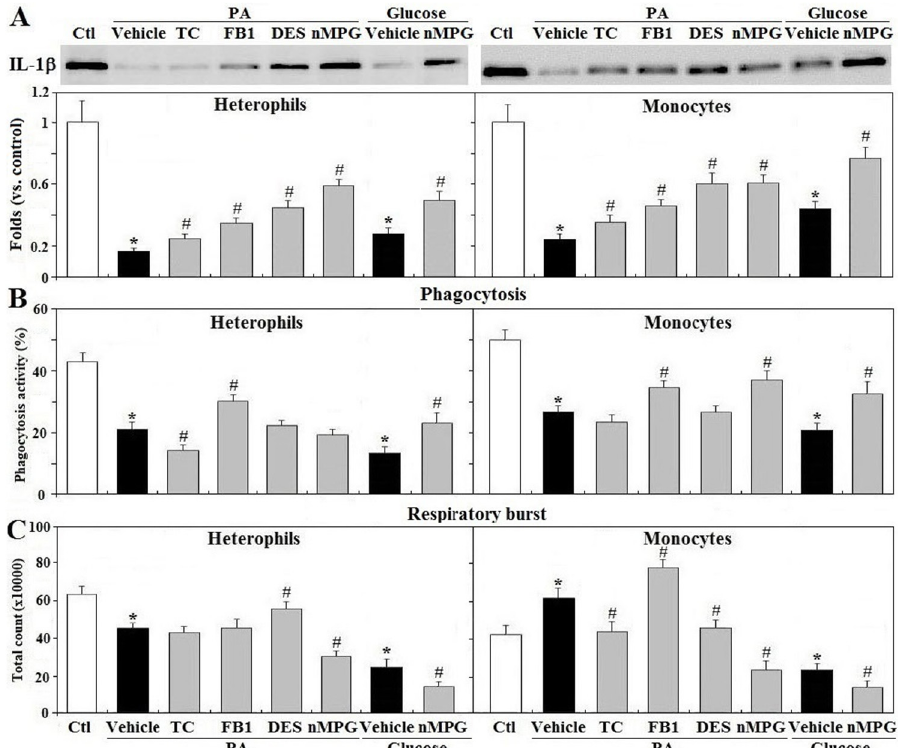
Figure 8. Mechanisms of glucolipotoxicity of leukocyte functions. Peripheral leukocytes (2 × 10 6 cells) from R-hens at age 61–65 weeks were pre-treated with TC (Triacsin C, 5 μ M), FB1 (fumonisin B1, 25 μ M), DPS (Desipramine, 10µM), or nMPG (N-mercaptopropionyl-glycine, 0.3 mM). After being replaced with the medium, cells were treated with the vehicle, palmitic acid (PA, 1.5 mM), or glucose (200 mg/dL) overnight (16 h). Media were collected for interleukin-1 β (IL-1 β ) analysis ( A ) by Western blot method based on equivalent amounts of protein and collected cells used for phagocytosis ( B ) and respiratory burst analysis ( C ) ( n = 4). Chemiluminescence results of respiratory burst analysis were expressed as integrated counts over 45 min. Results of Western blots were expressed as rations relative to control (Ctl). *; significant difference vs. corresponding control (vehicle), p < 0.05, #; significant difference vs. vehicle, p < 0.05.